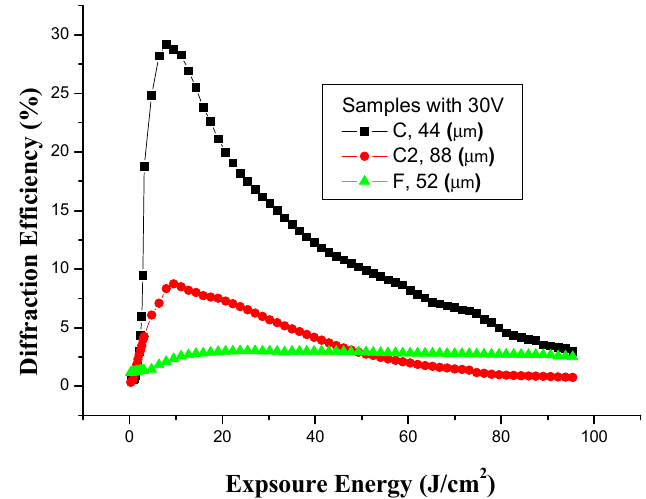
Figure 14. Diffraction efficiency with 30 V voltage, in the register process using copper electrodes (+) and ( − ) for different thicknesses, for grating with 454